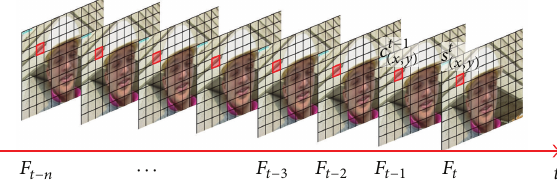
Figure 5: Schematic diagram of MBs with corresponding position in adjoining frames.